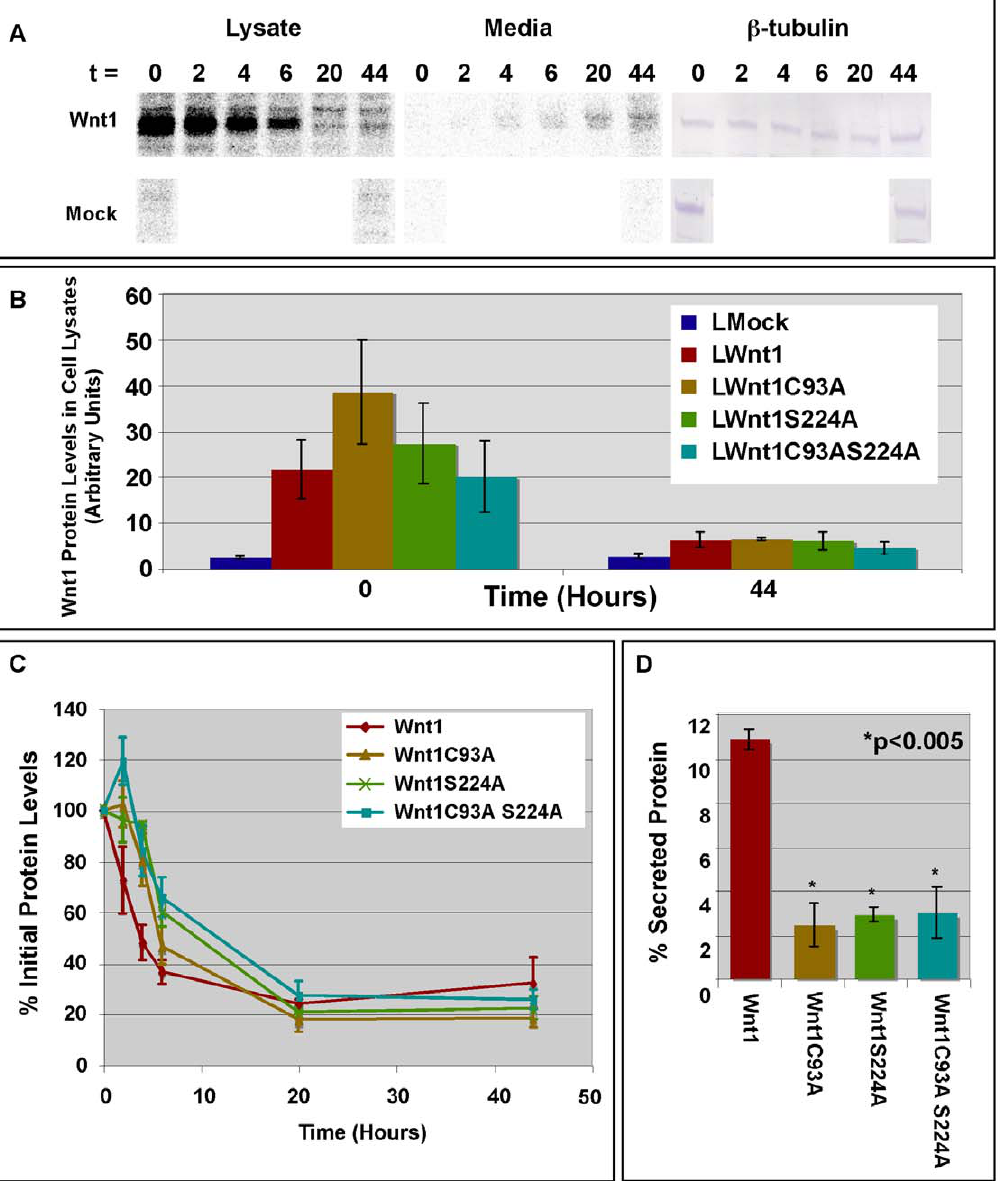
Figure 2. Pulse-chase analysis of Wnt1 stability and secretion. Panel A: Stably transfected L cells were pulsed with 35 S-cys and 35 S-met for 4 hours prior to chasing for 0–44 hours with unlabeled media. Wnt1 was immunoprecipitated from cell lysates and media using anti-Wnt1 monoclonal antibodies developed in our lab [7]. Immunoprecipitated protein was separated by SDS-PAGE and subjected to analysis with a Kodak STORM Phosphorimager. A representative scan for wild-type Wnt1 is shown. As a control, a Western blot of total protein in the cell lysates prior to immunoprecipitations was also performed using antibodies against ß-tubulin. Panel B: This graph shows quantitation of the radiolabel in each sample (lysateonly) as determined by Phosphorimaging. Data formock transfected L cells andWnt1 (wild-type andmutant) transfected L cells is shownforthe 0 and 44 hr time points. These data were not normalized in any way. Data from 2–3 independent replicates is shown; error bars show standard error. Panel C: This graph shows quantitation of the total radiolabel in each sample (lysate + medium) as determined by Phosphorimaging. Identical exposures were used for cell lysates and media. Values for time=0 are set to 100%. Data from 2 or 3 independent replicates is shown; error bars show the standard error. Panel D: This graph shows the percentof secreted Wnt1 protein (Medium max /Lysate max *100). Results from 2–3 independent replicates are shown. Error bars show standard error. The percentage of secreted Wnt1C93A, Wnt1S224A, and Wnt1C93AS224A are all significantly less than that of wild-type Wnt1 (p , 0.005). However, there are no statistically significant differences between the various mutant Wnt1 proteins. doi:10.1371/journal.pone.0026636.g002 mutant Wnt1 (Fig. 2B). Though Wnt1 C93A showed slightly higher using identical exposure times for all samples (Fig. 2). A representative levels than wild-type Wnt1, Wnt1 S224A, and Wnt1 C93AS224A scan is shown for wild-type Wnt1 in Fig. 2A. Scans for wild-type and (Fig. 2B), these differences were not statistically significant. As mutant Wnt1 were quantitated for all time points. Importantly, our expected, the levels of wild-type and mutant Wnt1 in cell lysates were data show that at the start of the chase (t=0), each of the L cell clones dramatically reduced after 44 hrs of chase (Fig. 2B). chosen for analysis showed roughly equal levels of wild-type and